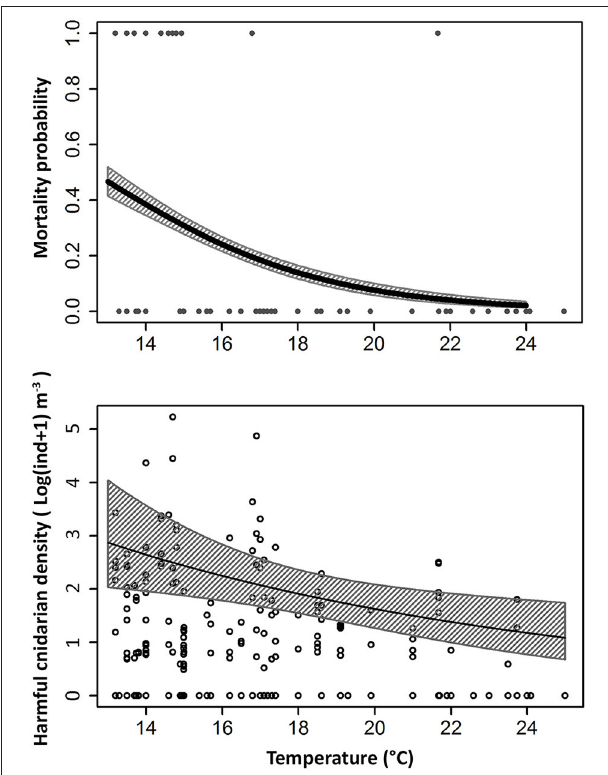
FIGURE 5 | Probability of fish mortality event at different water temperatures (above) and relationship between harmful cnidarian densities and water temperature